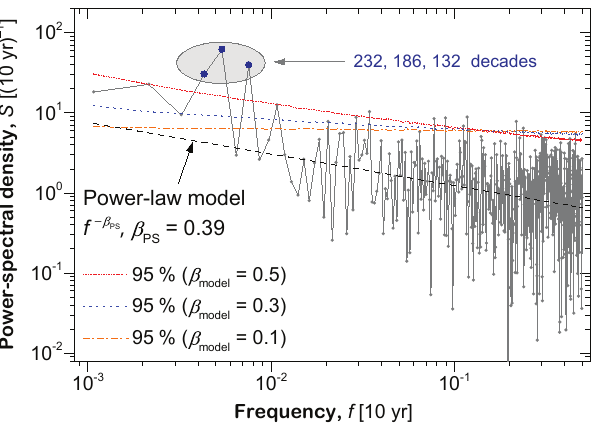
Figure 9. Power-spectral analysis: the power-spectral density (peri- odogram) is presented as a function of the frequency (measured per decade) for the number of floods per decade. Also given is the best- fitting power-law function (Eq. 8) and the corresponding power-law exponent. Additionally, presented are the 95th percentiles of the power spectra created for synthetic data based on peaks over thresh- olds of fractional noises (see Sect. 5.1) for different strengths of per- sistence (see the legend and the description in the text). Highlighted are the three values of the power-spectral density that exceed all of these 95th percentiles; the corresponding cycle lengths are given.